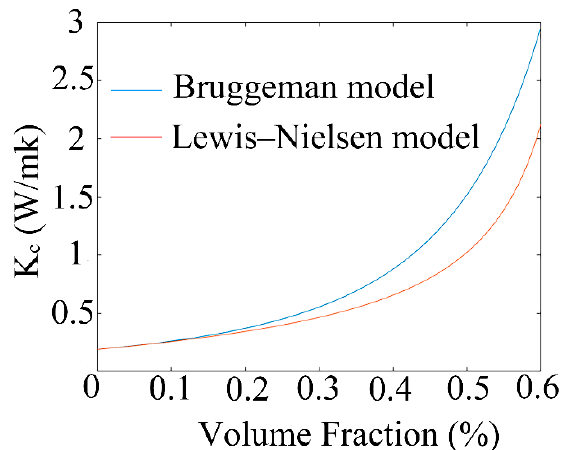
Figure 1. Calculated thermal conductivity of composites with different volume fractions of graphene filler.